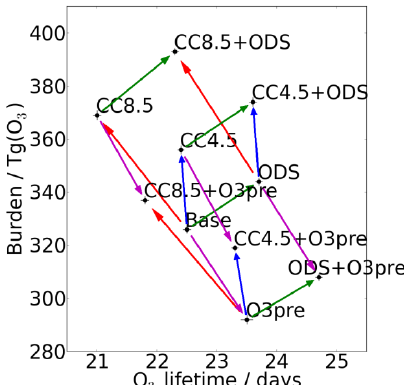
Figure 9. Tropospheric ozone burden against the ozone lifetime. Arrows indicate the impact of climate change at RCP4.5 (blue) and RCP8.5 (red), reduced ODS loadings (green) and reduced ozone precursor emissions (magenta). Error bars indicate the 5–95% con- fidence interval, calculated as ± 1.96 times the standard error in the mean.